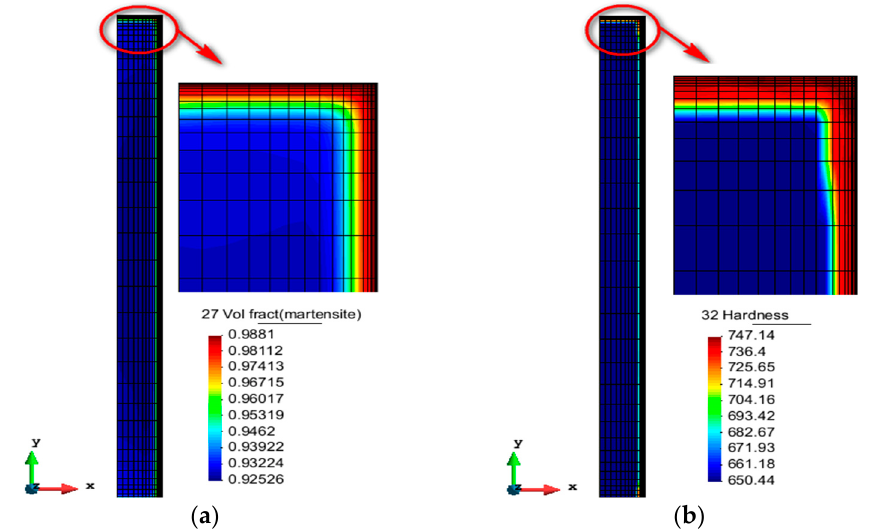
Figure 8. Martensite and hardness content distribution of process 2. ( a ) Martensite; ( b ) Hardness.